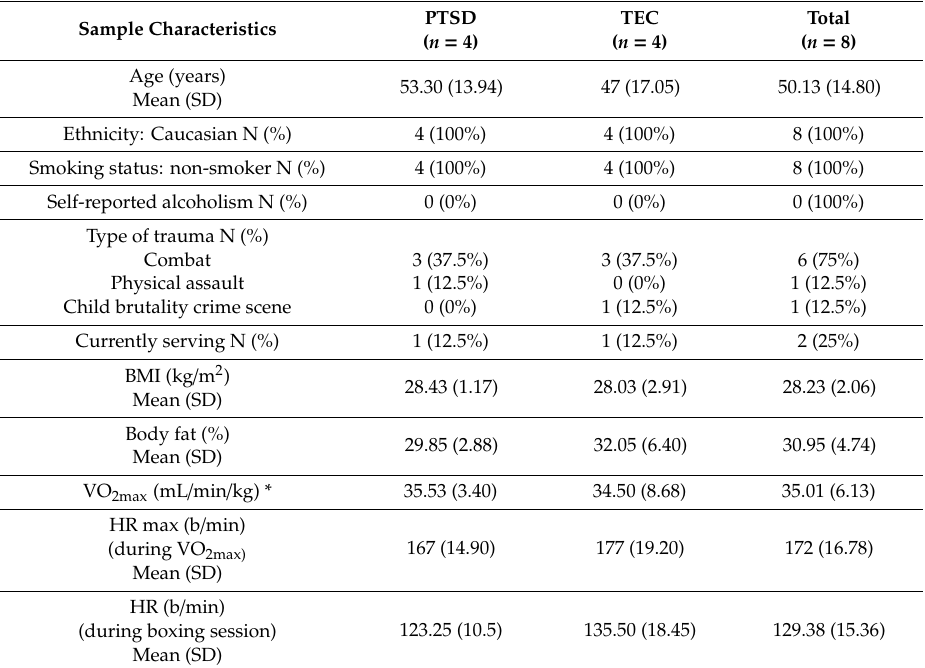
Table 1. Participant